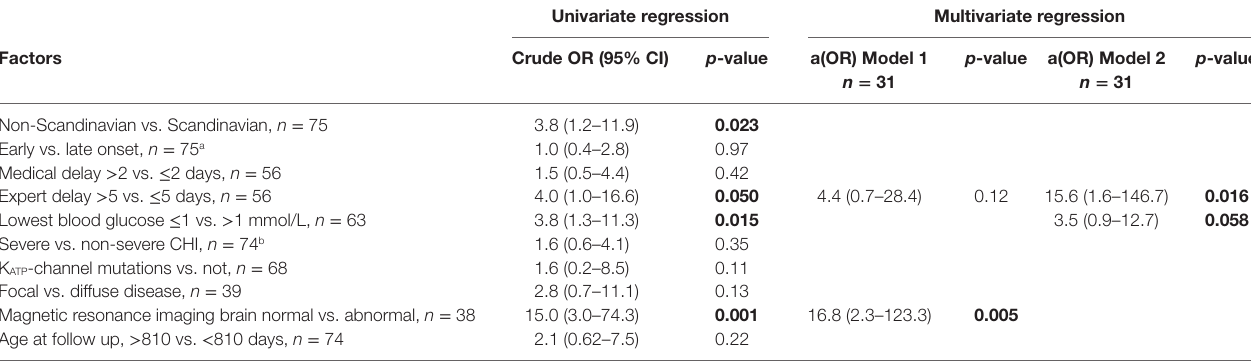
TaBle 7 | Logistic regression for factors associated to neurodevelopmental impairment in congenital hyperinsulinism (CHI) patients. Univariate